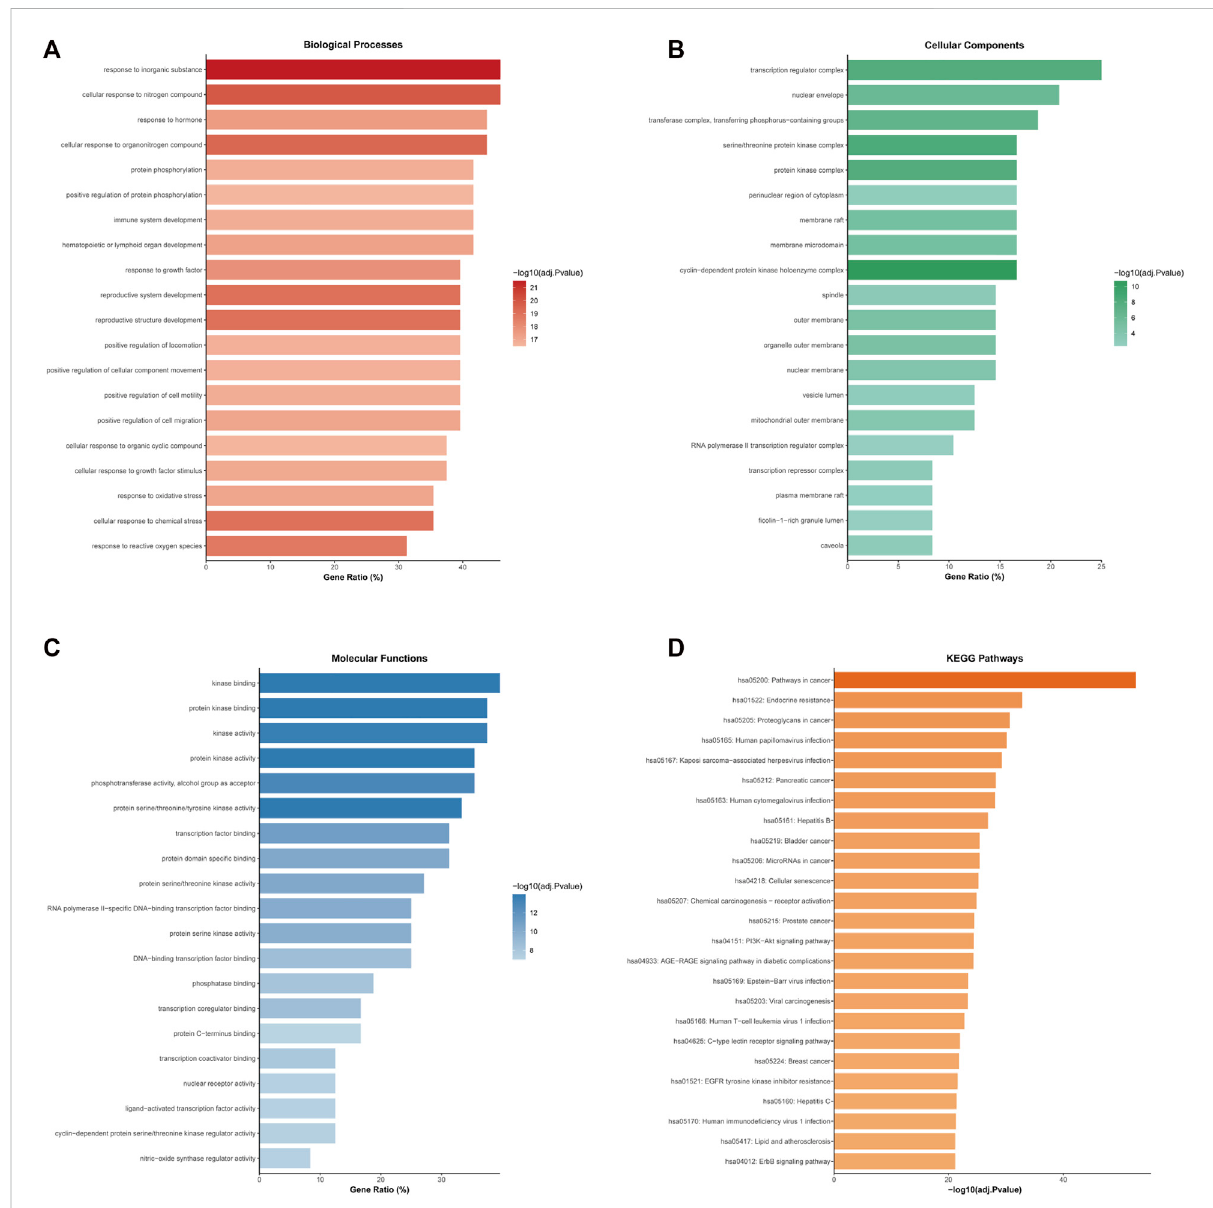
FIGURE 5 Enrichment analyses of Cluster One for the top 20 GO annotations and top 25 KEGG pathways (A) GO analysis of biological process terms (B) GO analysis of cellular component terms (C) GO analysis of molecular function terms (D) KEGG pathway